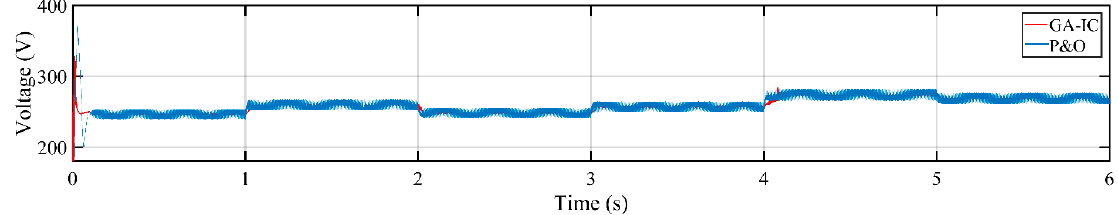
Figure 34. Case 3 voltage comparison of modified GA-IC vs. P&O.